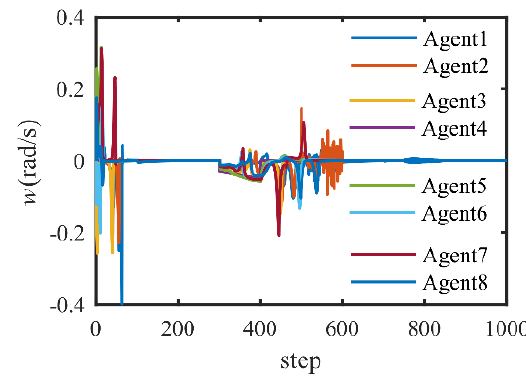
Figure 9. Angular rate (test 2).